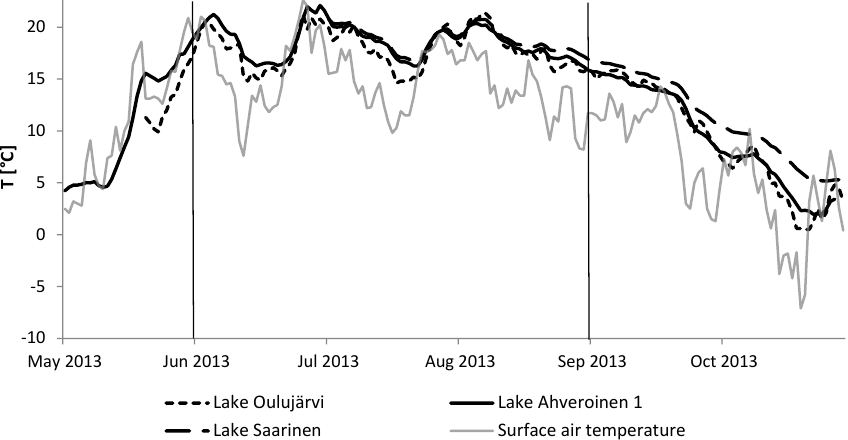
Figure 3. Daily mean surface water temperatures of lakes Oulujärvi (92800ha) (Finnish Environmental Institute, 2013), Ahveroinen 1 (3.3ha) and Saarinen (15.3ha) during the summer of 2013, compared with the surface air temperature data for the same period. Lake Oulujärvi is located in the east, next to the study site, 1km from the easternmost lake studied. Vertical lines mark the period used in the calculations of evaporation and isotope mass balance.